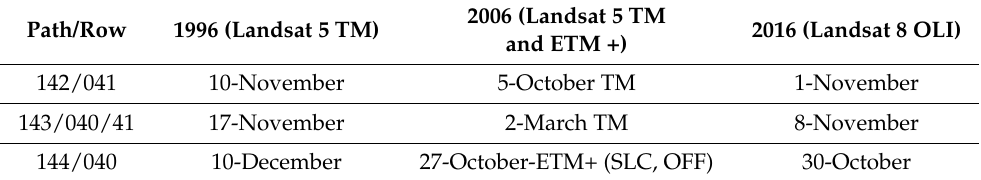
Table 1. Satellite images.